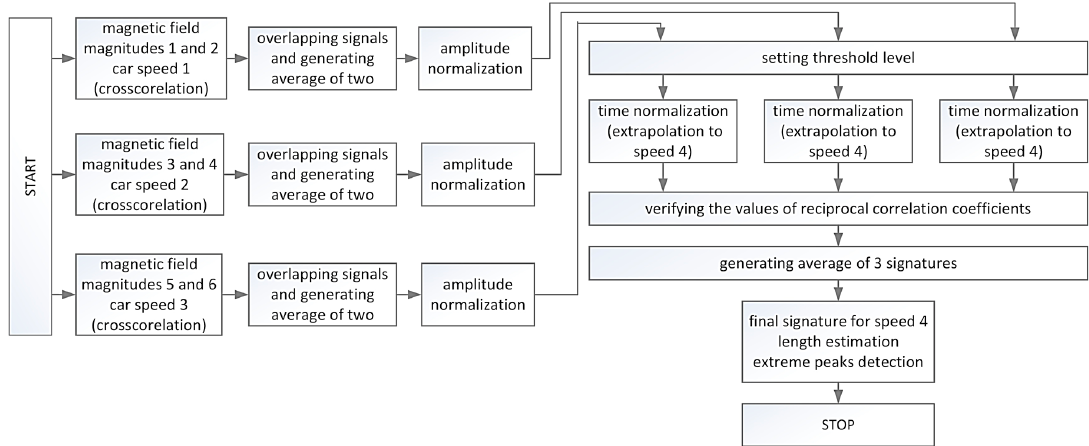
Figure 9 . Algorithm for finding a car signature at one normalized speed basing on the magnetic field (data registered using one car and three drives at three different speeds).